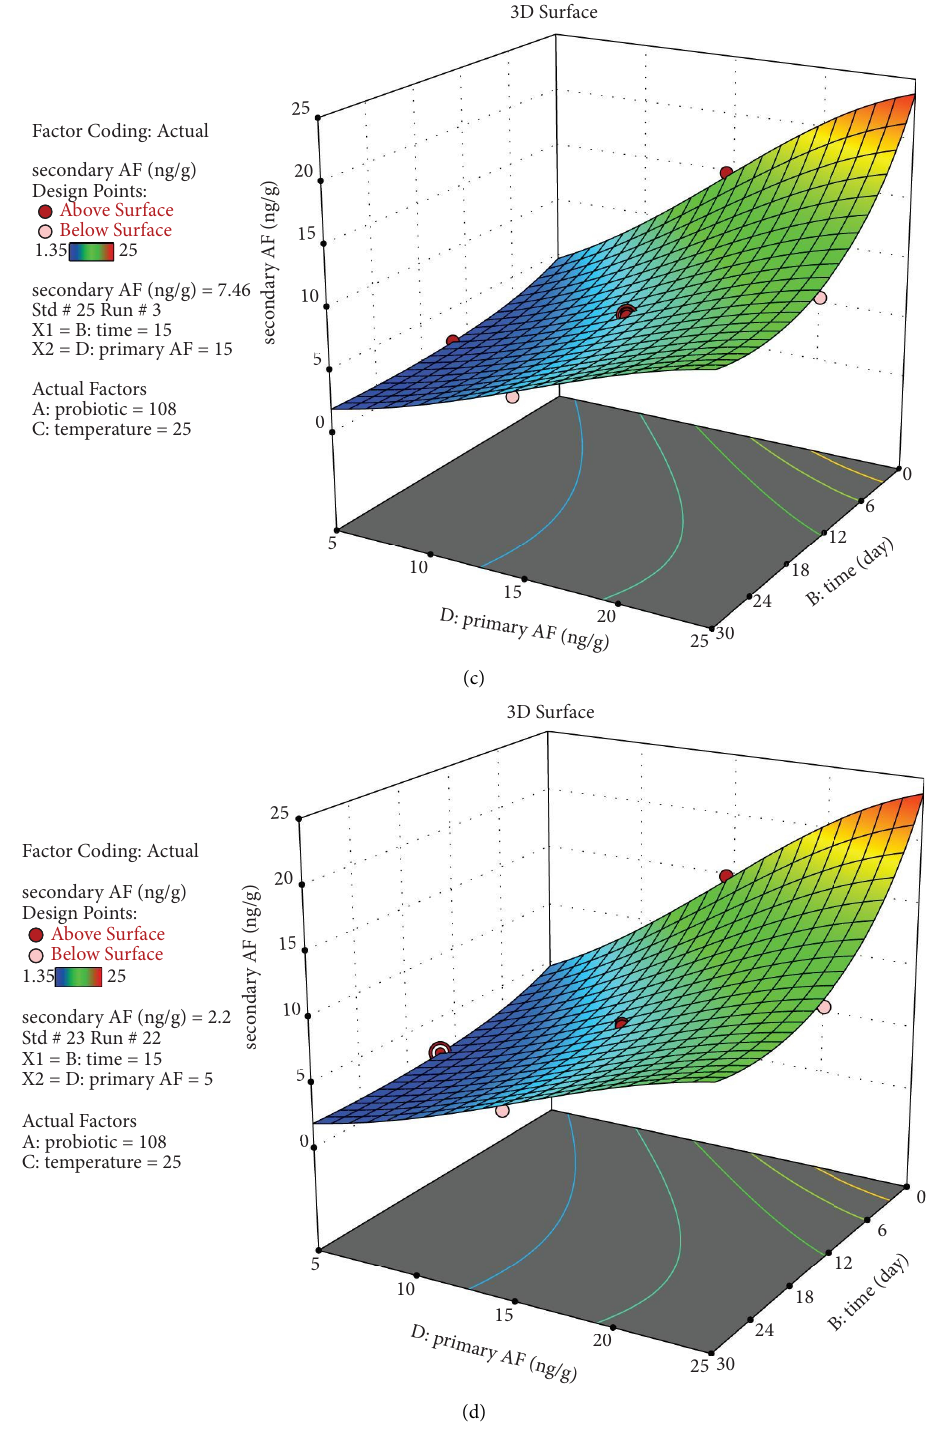
Figure 5: Interaction of probiotic content (10 8 CFU/g) and the storage temperature (25 ° C) on the afatoxin residue in pistachio